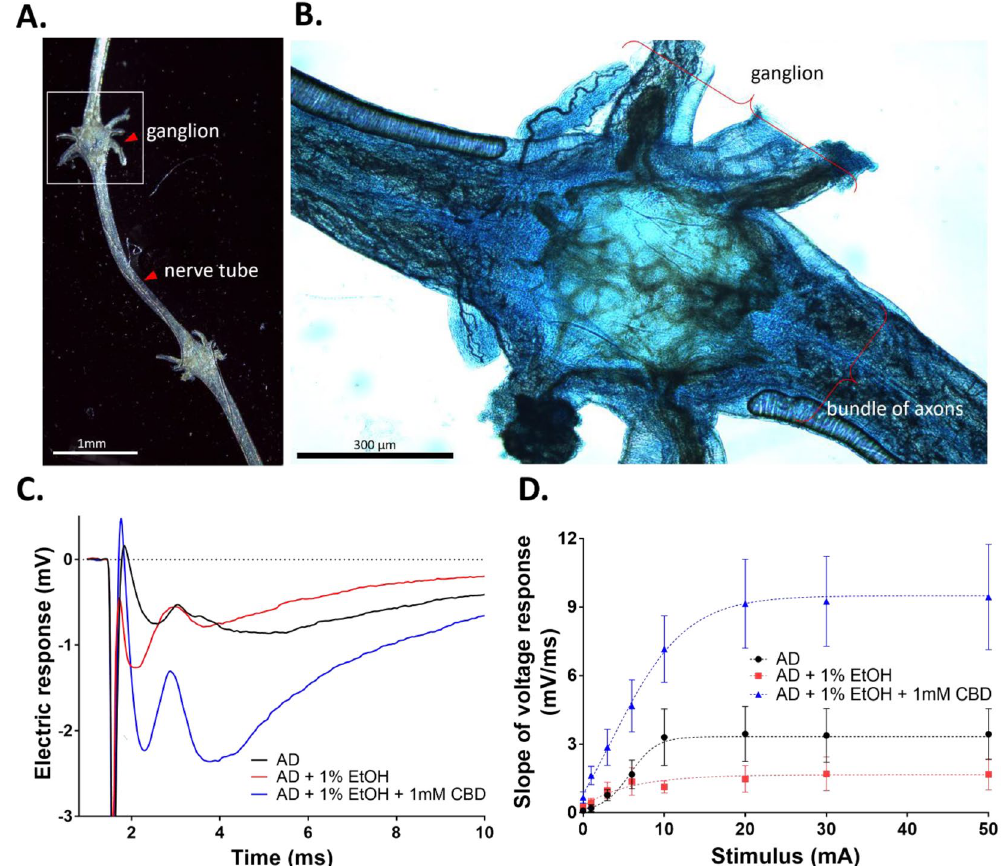
Figure 5. CBD increases electrophysiological responses measured in the ventral chain ganglia of M . sexta larvae. ( A ) A low power microscopic image of a 5 th -instar chain ganglion which was micro dissected from the larva, and annotation showing where the stimulating electrode was placed in the ganglion, and where the nerve tube was cut and drawn into the recording electrode. ( B ) A high power image of a methylene blue-stained ganglion. ( C ) Representative voltage responses following electrical stimulation of ganglia from the M . sexta fed on AD, AD + 1% EtOH, and AD + 1% EtOH + 1 mM CBD (one-way ANOVA, n = 5, p < 0.05). ( D ) The slope of the negative voltage response plotted as a function the stimulus intensity to quantify the input-output relationships within each treatment group (one-way ANOVA, n = 5, p <